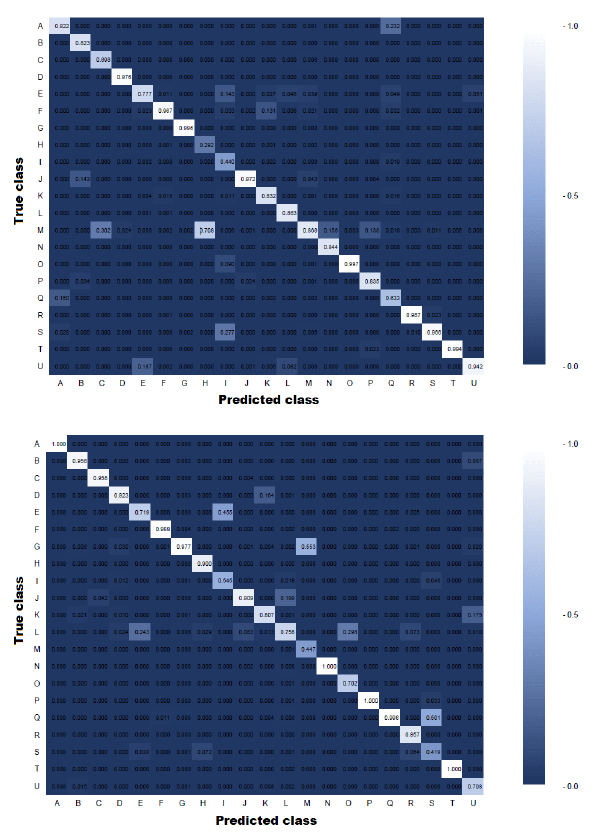
Figure 7. Normalised confusion matrix for our internal dataset ( top ) and 2D3DS dataset ( bottom